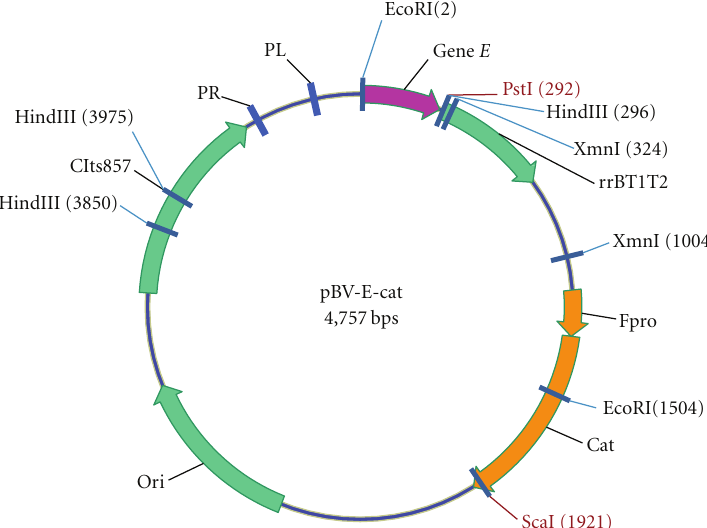
Figure 1: Physical map of the lysis plasmid pBV E cat. Gene E , under transcriptional control of the temperature-sensitive repressor; rrBT1T2 : ribosome rrnB gene providing translation stop signal terminator sequence; pro : the regulating sequence including promoter; cat : chloramphenicol acetyl transferase gene; ori : replication origin; cIts857 : restraining gene of lambda bacteriophage adapted to heat induced